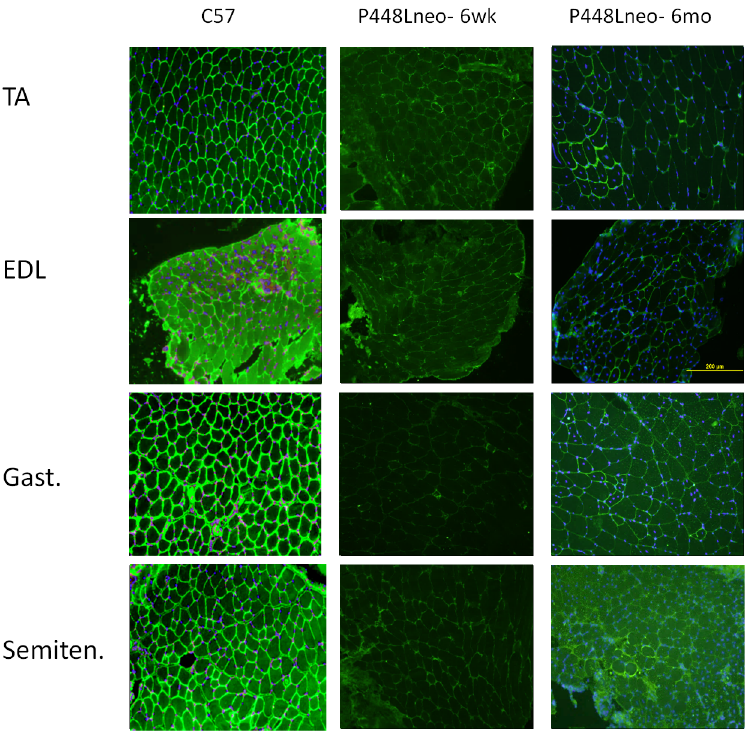
Fig 1. Presence of revertant fibers in hindlimb muscles of P448Lneo- mutant mouse. Tibialis anterior (TA), extensor digitorum longus (EDL), gastrocnemius (Gast.), and semitendinosus (Semiten.). Strong IIH6 staining shown in all muscle of C57, but almost absent in both 6 week and 6 month old P448Lneo-. Varying numbers of revertant fibers seen at the different ages of P448Lneo- . Images displayed at 20X magnification. Yellow bar (shown in 6 month EDL) represents 200